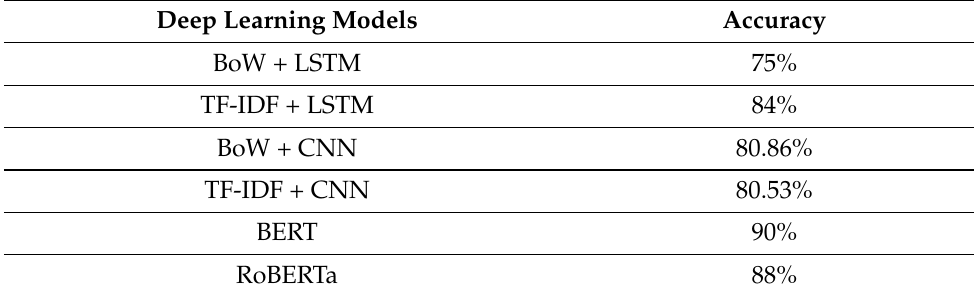
Table 17. Comparison among deep learning models.